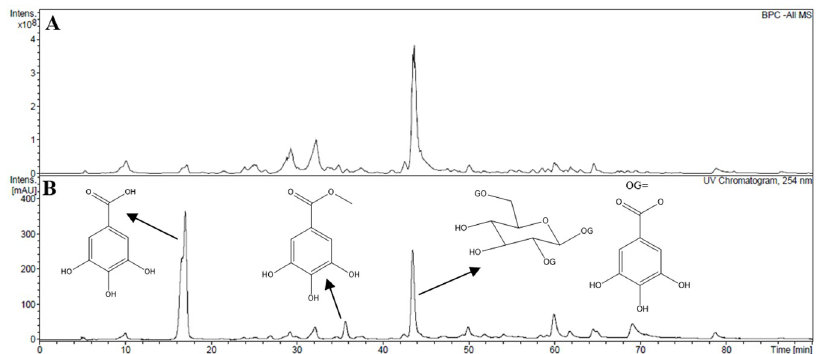
Fig 1. Base peak chromatograms (BPC) in negative ion mode (A) and DAD chromatogram at 254 nm (B) of ethyl ether fraction from leaves of D . vandellianum by HPLC-DAD-ESIMS n . In (B), the peaks corresponding to gallic acid, methyl gallate and 1,2,6-tri-O-galloyl- β - D -glucopyranose was demonstrated.